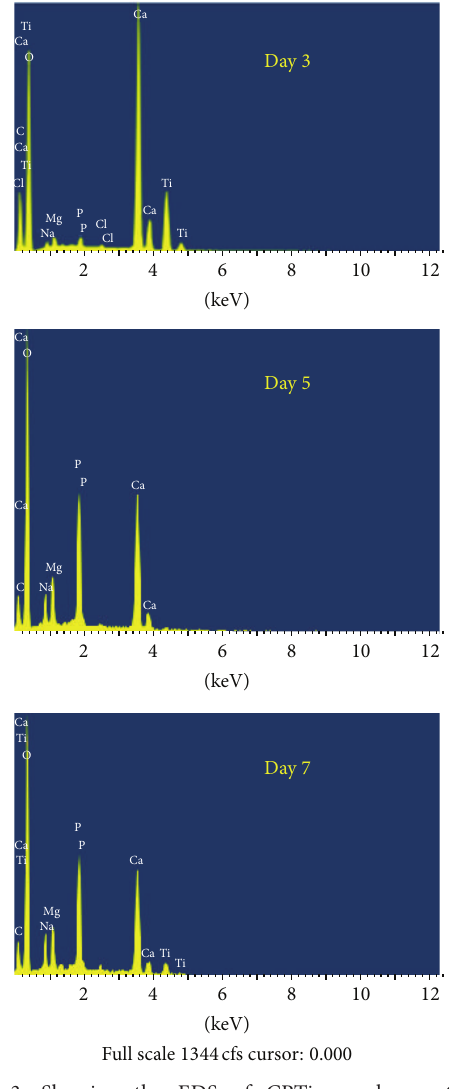
Figure 3: Showing the EDS of CPTi samples coated with HA/tricalcium